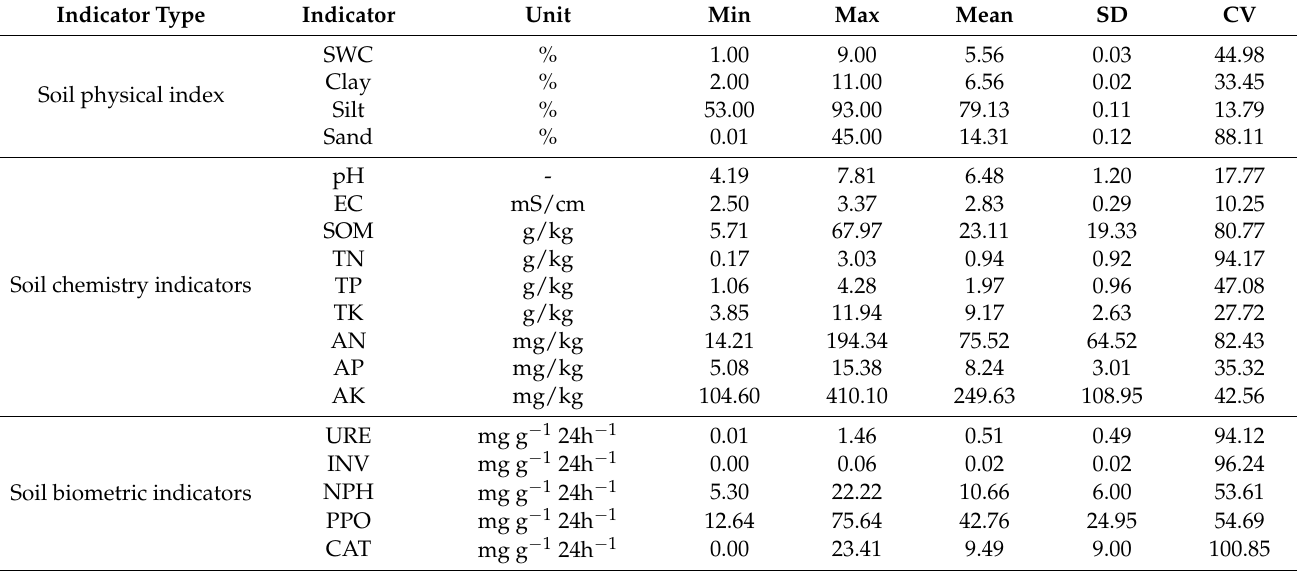
Table 2. Statistical characteristics of soil quality evaluation indexes ( n =